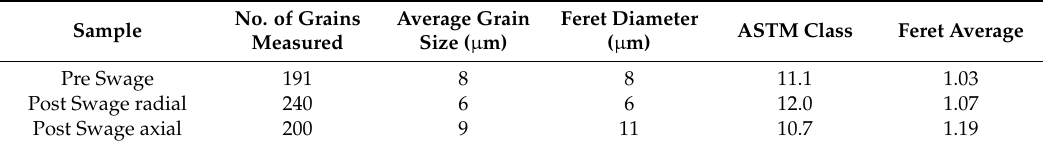
Table 2. Pre and post swaging grain size data.